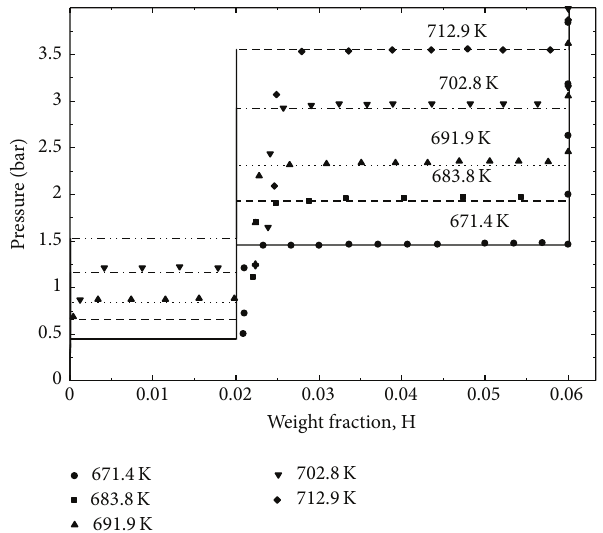
Figure 9: The calculated phase diagram for Mg-Na system in comparison with the experimental Data.